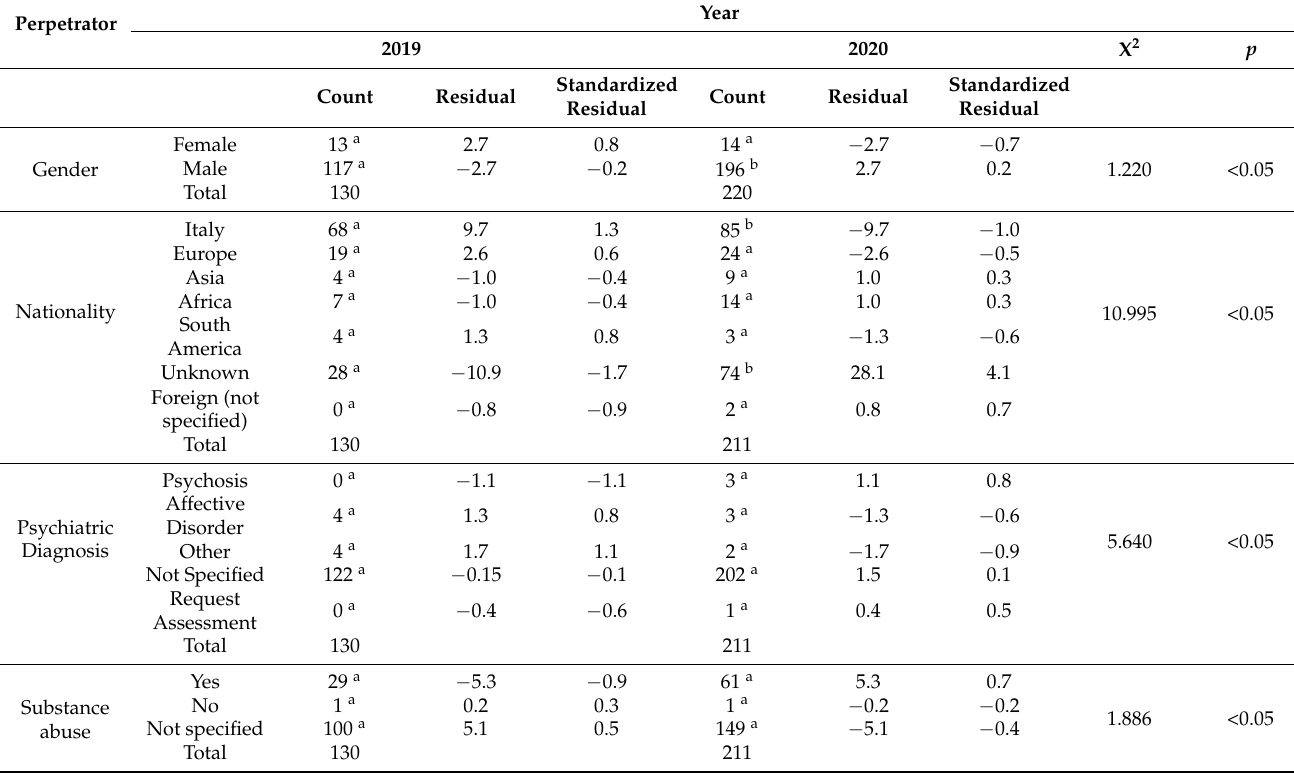
Table 1. Information about the perpetrators by